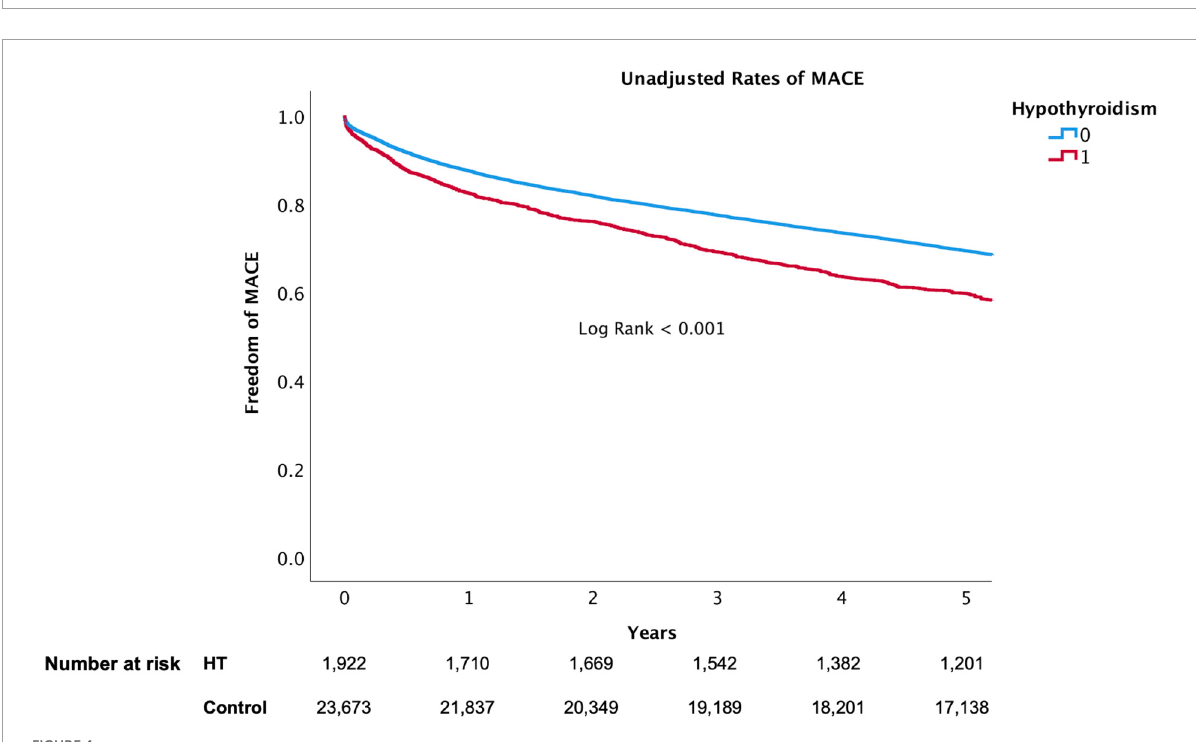
FIGURE4 5-Year MACE of hypothyroidism versus euthyroid patients.